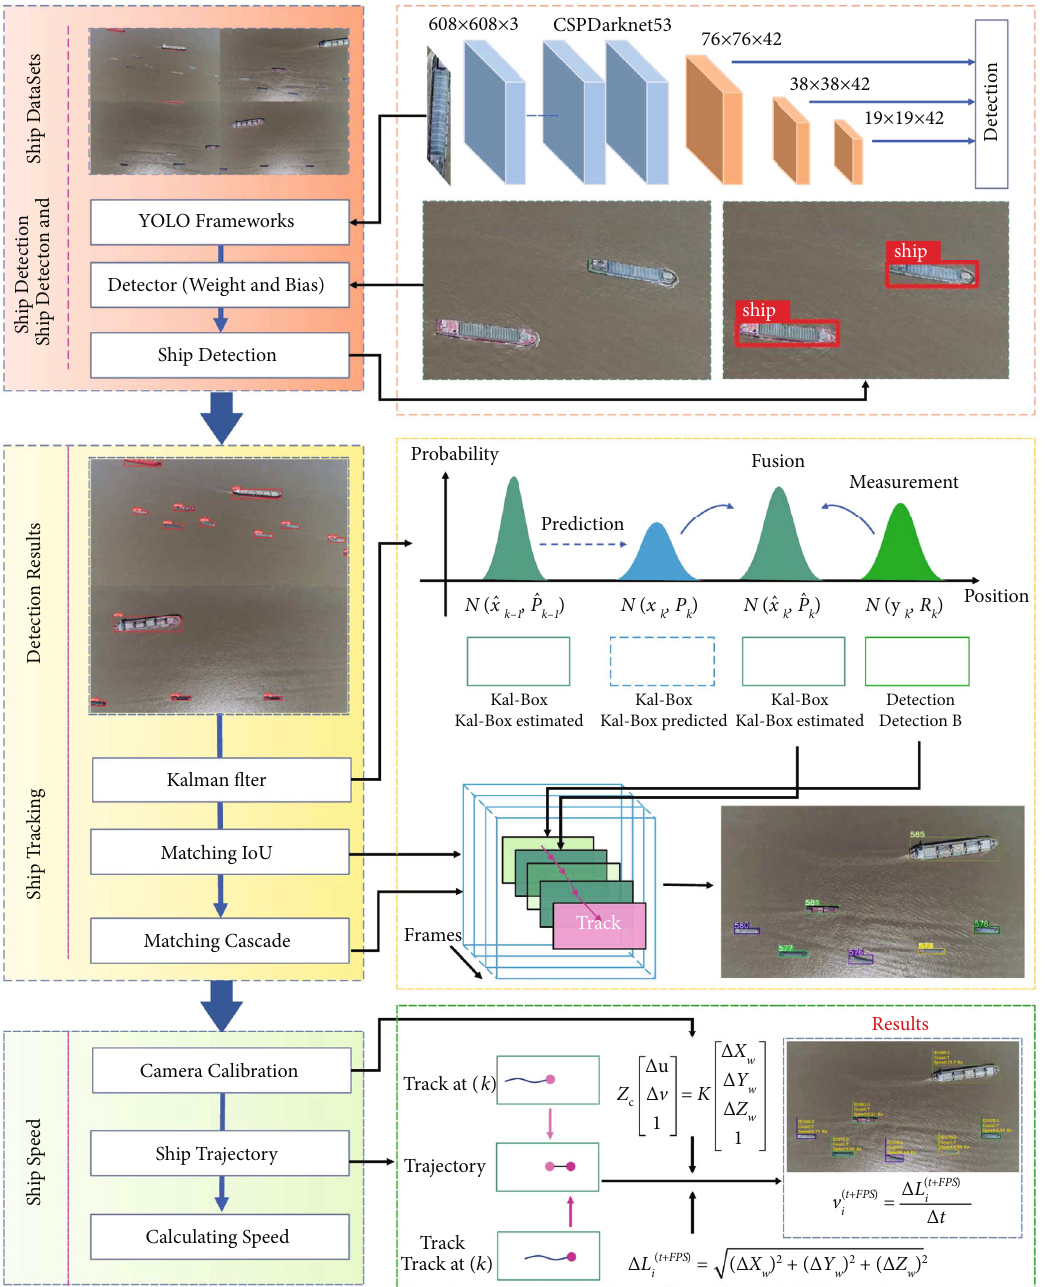
Figure 1: Research